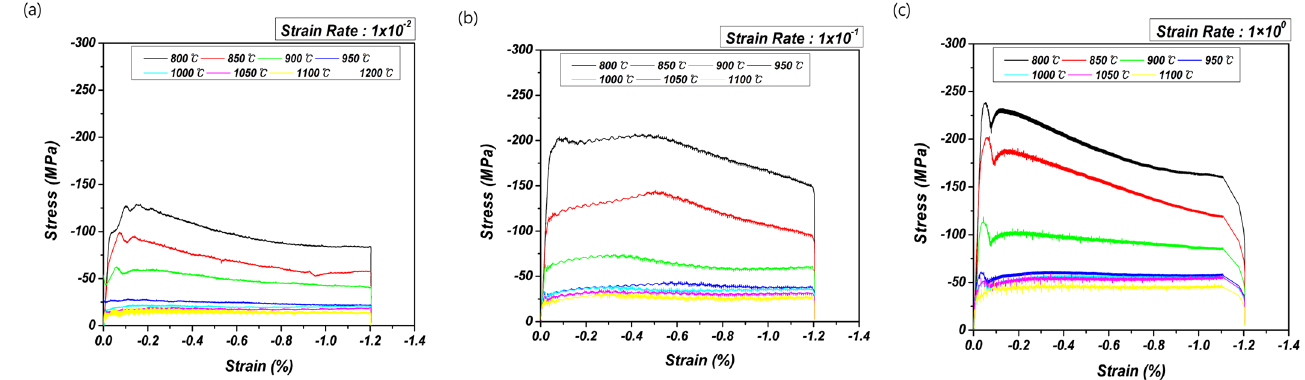
Figure 5. True stress–strain curves of Ti ‐ 6Al ‐ 4V alloy at various temperatures and strain rates; ( a ) strain rate 1 (cid:3400) 10 (cid:2879)(cid:2870) /s , ( b ) strain rate 1 (cid:3400) 10 (cid:2879)(cid:2869) /s , ( c ) strain rate 1 (cid:3400) 10 (cid:2868) /s . ( a ) strain rate 1 × 10 − 2 /s, ( b ) strain rate 1 × 10 − 1 /s, ( c ) strain rate 1 × 10 0